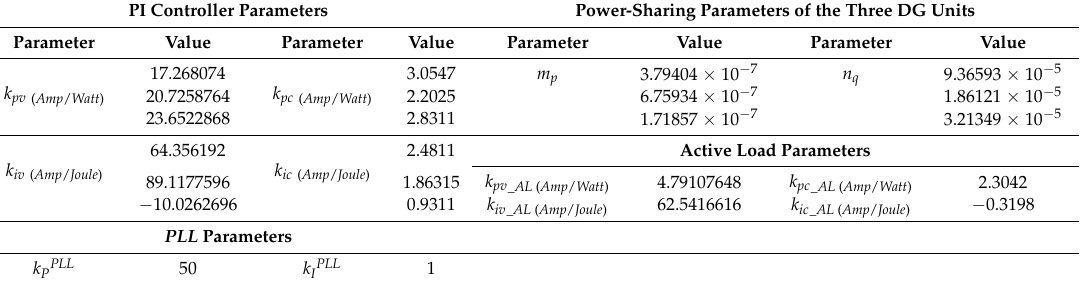
Table 2. Optimal